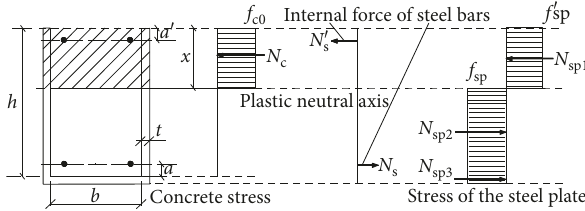
Figure 6: Calculation chart of ultimate moment. both sides of the compression zone as M , the resistance sp1 moment of the webs on both sides of the tensile zone as M , and the resistance moment of base plate of the bottom sp2 flanges as M ; a represents the distance from the resultant sp3 point of longitudinal tensile reinforcement to the near side of the section.